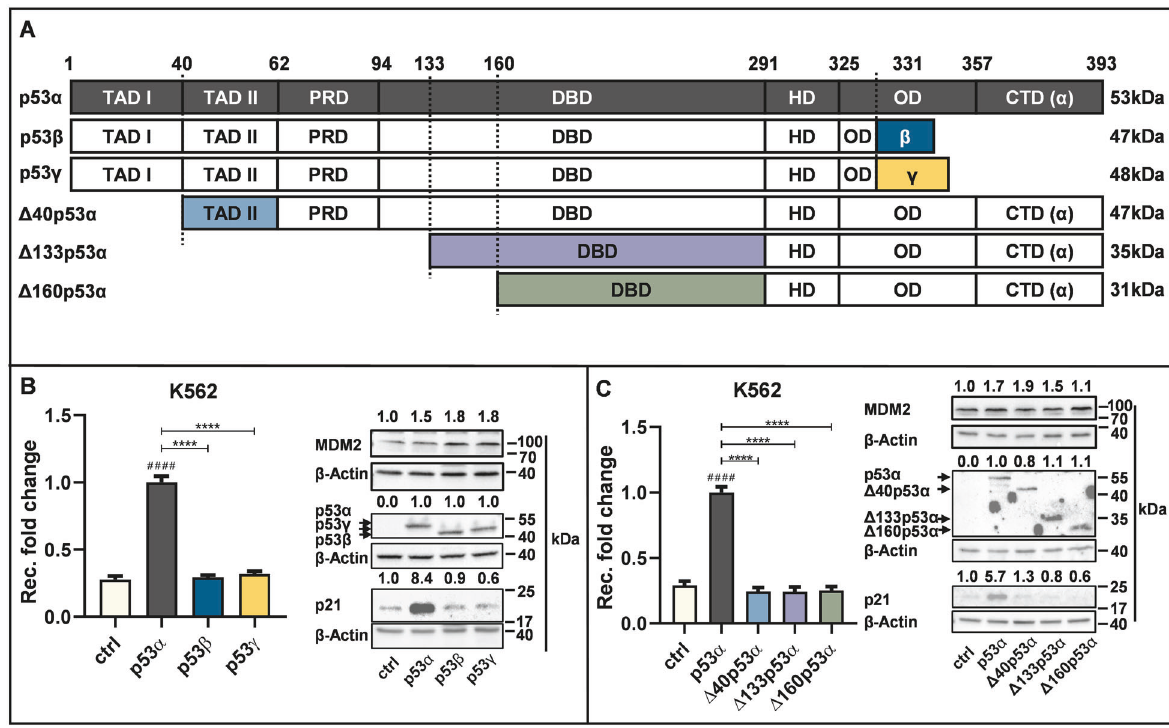
Fig. 1 Analysis of the p53 isoforms p53 α , p53 β , p53 γ , Δ 40p53 α , Δ 133p53 α , and Δ 160p53 α in replication-associated recombination. K562 ( HR-EGFP/3 ′ -EGFP ) cells were transfected with 10 µg expression plasmid for p53 α and corresponding amounts for p53 β , p53 γ , Δ 40p53 α , Δ 133p53 α , Δ 160p53 α or empty vector (EV) in controls (ctrl) as indicated in the graphs. Seventy-two hours after transfection FACS analysis (left panels of B , C ) and protein harvesting (right panels of B , C ) were performed. Recombination (rec.) fold changes were analyzed fl ow cytometrically by quanti fi cation of EGFP-positive cells among living cells. Mean values from p53 α -expressing cells were set to 1 (absolute mean frequencies: 4*10 − 5 ). Data were collected from ≥ 18 individual measurements each. For graphic presentation, calculation of SEM and statistically signi fi cant differences via Kruskal-Wallis test followed by two-tailed Mann − Whitney U test GraphPadPrism8.4 software was used. # indicates a statistically signi fi cant difference between ctrl and the respective p53-isoform data. ****(# # # #) P < 0.0001. Quanti fi cation of protein levels was carried out using ImageLab software, normalized to β -actin, and indicated above the representative immunoblot. A Schematic overview of different domains of p53 isoforms. p53 α (highlighted in black) consists of transactivation domain I (TAD